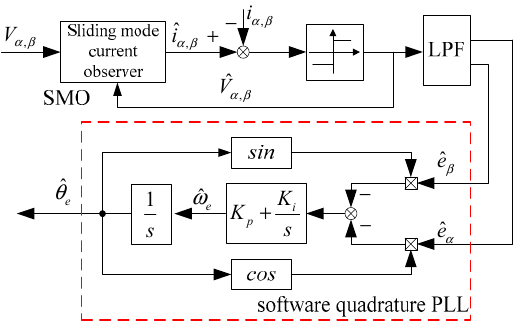
Figure 2. Conventional position and speed estimate based on sliding-mode observer (SMO) and quadrature phase-locked loop (PLL).